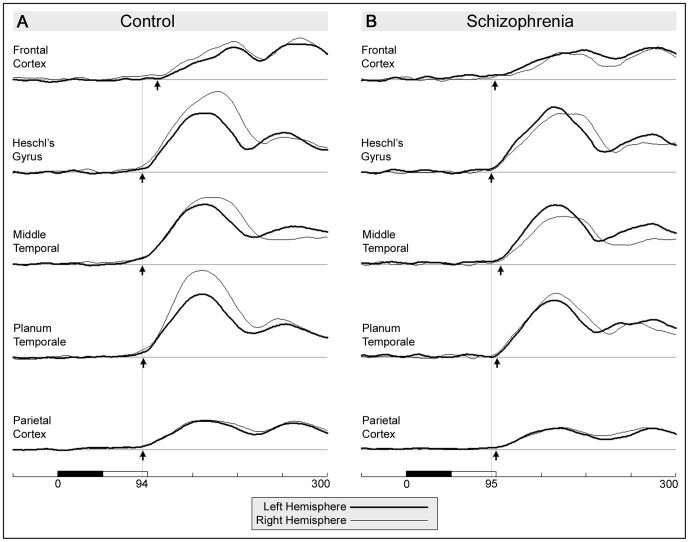
Temporal course of CSD in five ROIs for control and schizophrenia groups.Left hemisphere overlaid on right hemisphere. Small arrows indicate onset latency in each ROI estimated using piecewise linear regression. Vertical lines indicate onset latency in Heschl's gyrus for each group. (A) Average across both Control groups, (B) Average across both Patient Groups.